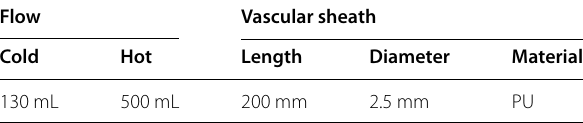
Table 7 Experimental parameters Flow